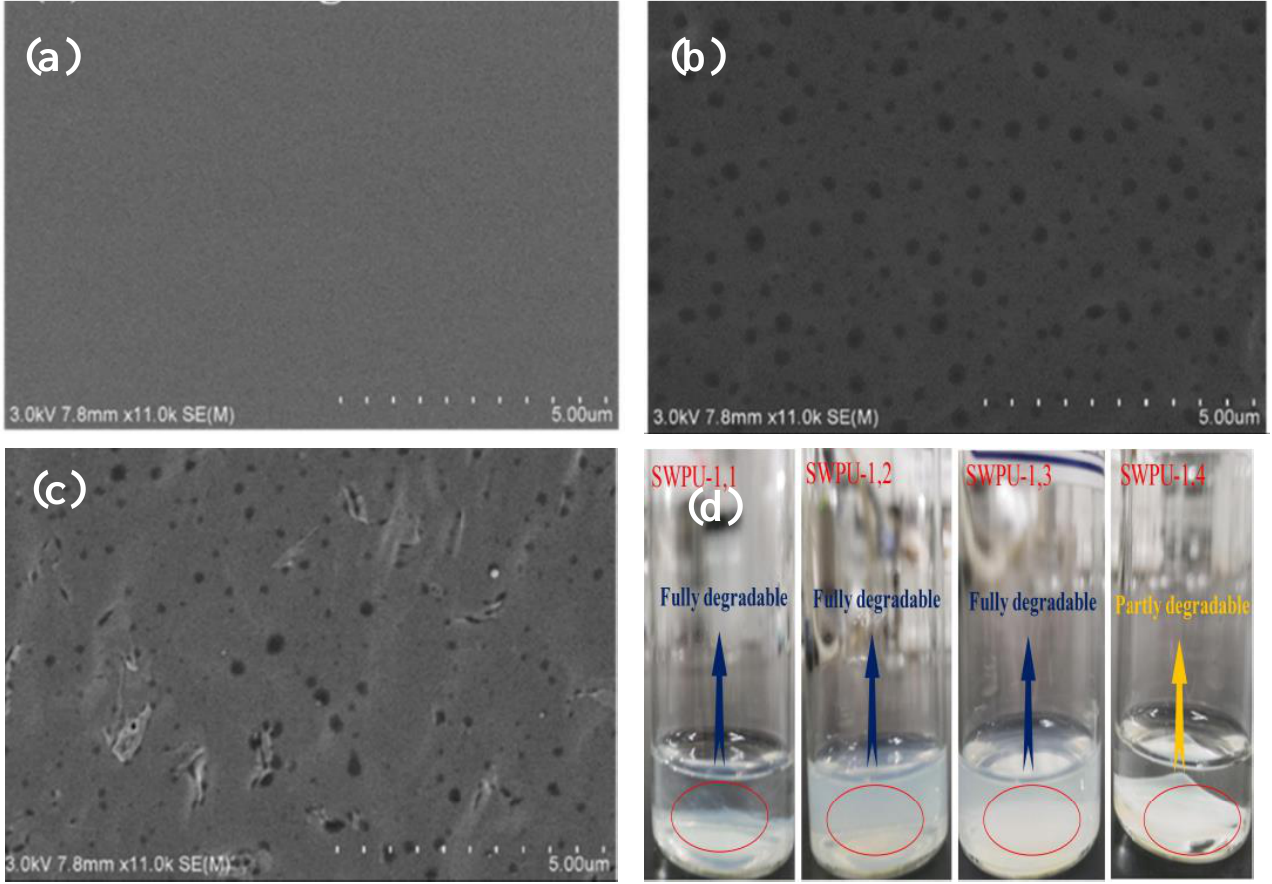
Figure 14. SEM images of PUDs films: ( a ) Before degradation; ( b ) PUDs-1.2 film after 24 h degradation time; ( c ) PUDs-1.4 film after 24 h degradation time; ( d ) PUDs films in a 5 wt.% NaOH solution for 8 h (adapted with permission from [97]).